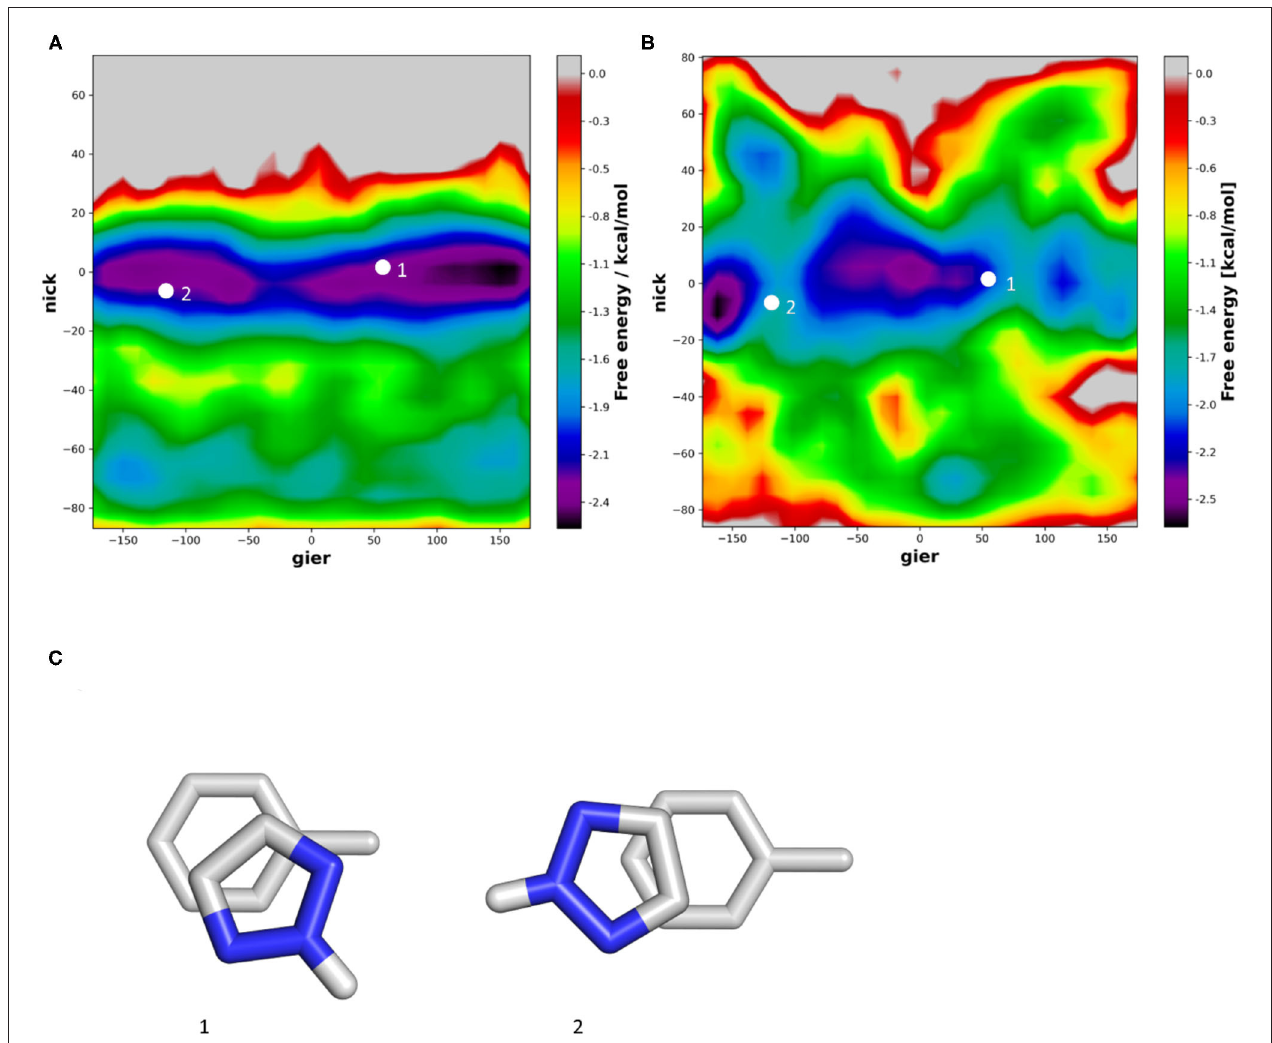
FIGURE 7 | 2D-histogram analysis of the nick and gier angles of triazole during the molecular dynamics simulations of the stacking interactions with toluene in vacuum (A) and in water (B) . (C) Shows the optimized geometries obtained from a grid-based optimization approach in vacuum.